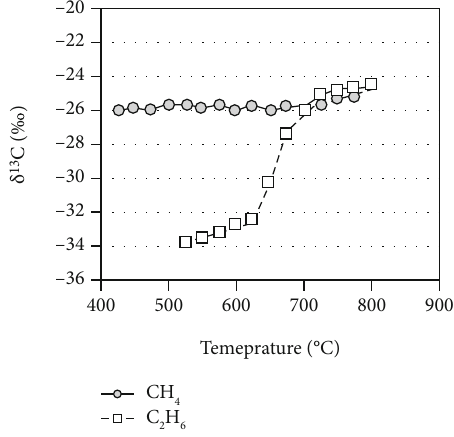
Figure 3: Variation in δ 13 C temperature.